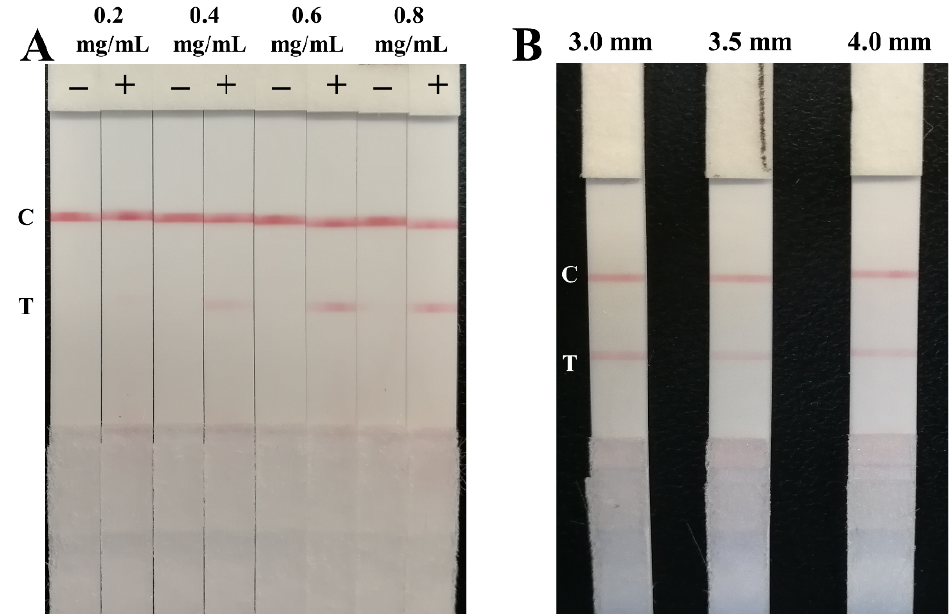
Figure 4. Optimization of the antibody II amount on the test line ( A ) and the width of LFIA test strip ( B ).